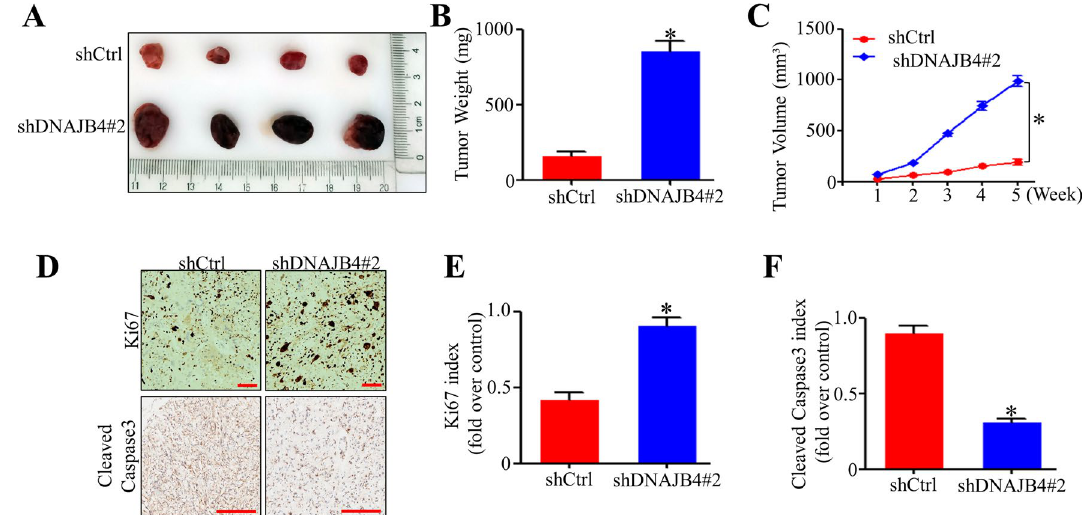
Fig. 4 DNAJB4 knockdown promotes the tumorigenicity of TNBC cells in vivo . A Representative images of the corresponding xenografts in the shCtrl and shDNAJB4 groups (n = 4). B The weight of tumors in the shCtrl and shDNAJB4 groups. Bar graph data are presented as the mean ± SEM; *, P < 0.05. C The growth curve of the tumors in the shCtrl and shDNAJB4 groups. Bar graph data are presented as the mean ± SEM; *, P < 0.05. D – F The Ki67 and Cleaved Caspase3 expression levels were determined in xenograft model tumor tissues by immu- nohistochemistry. All data are presented as the mean ± SEM; *, P < 0.05. Scale bars, 100 μm (200 × magnification) for